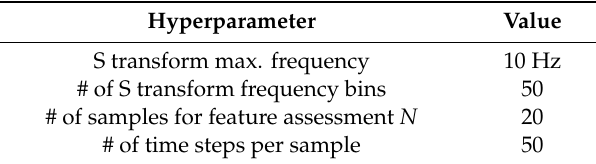
Table 9. Hyperparameters used for the disturbance detection